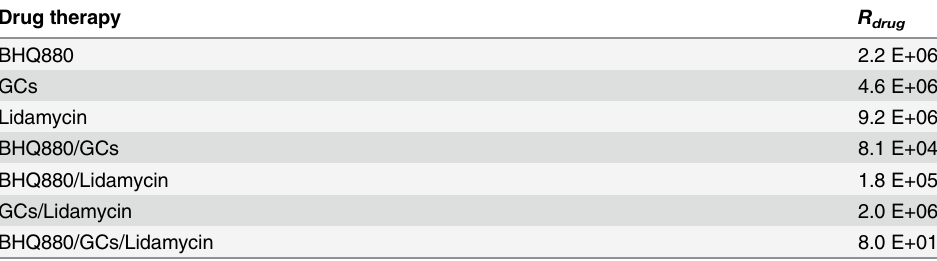
), and the drug uptake rate ( U ( λ d Table 2. Response of R drug to different drug